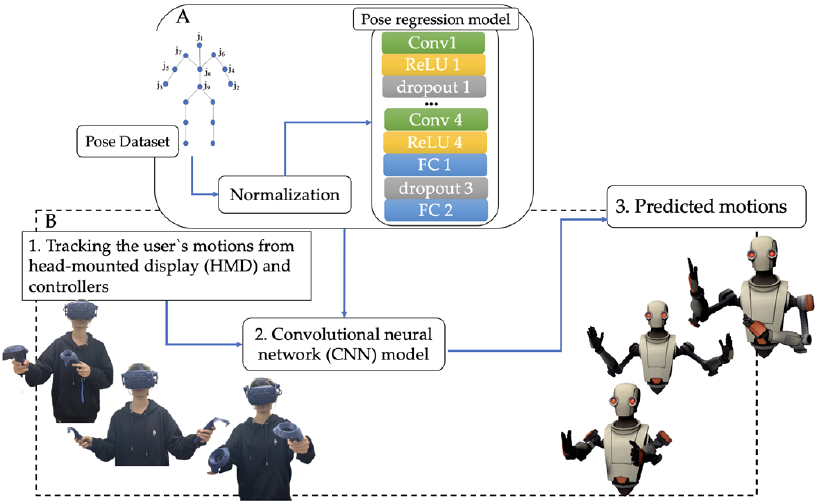
Figure 1. Our proposed pose estimation method for an avatar. Part A is network architecture for pose regression and Part B is the avatar animation step.